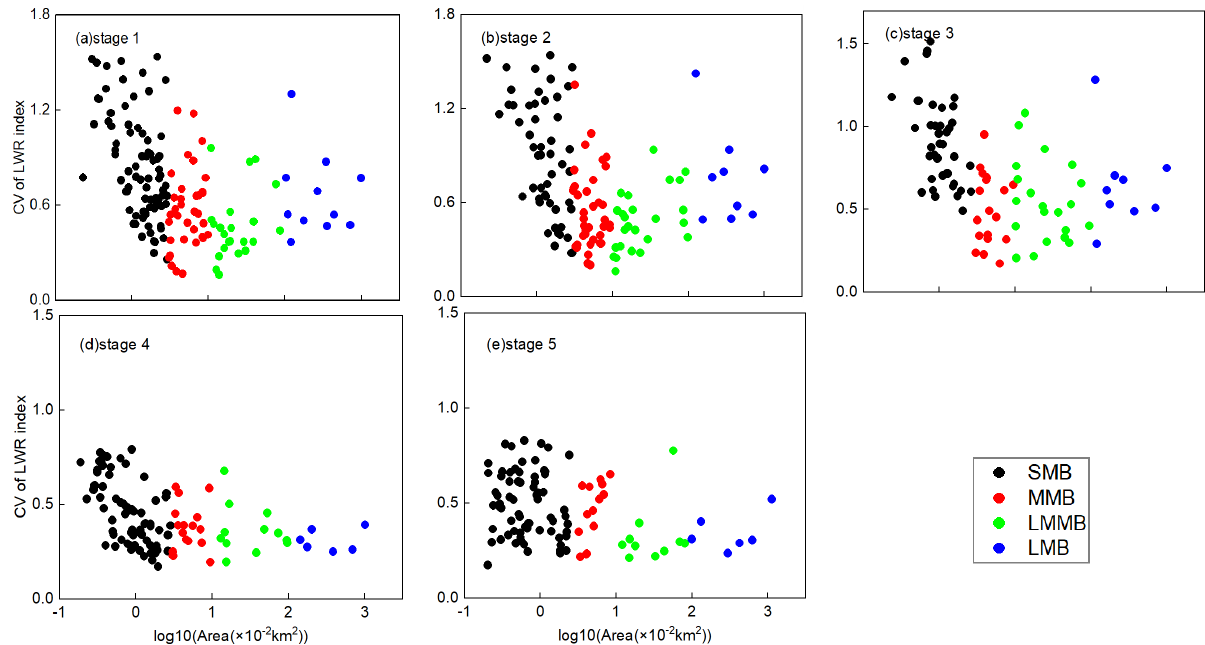
Figure 6. Relationship between CV of LWR and area of MCBs with different sizes in different impoundment periods: ( a ) stage 1, ( b ) stage 2, ( c ) stage 3, ( d ) stage 4 and ( e ) stage 5.